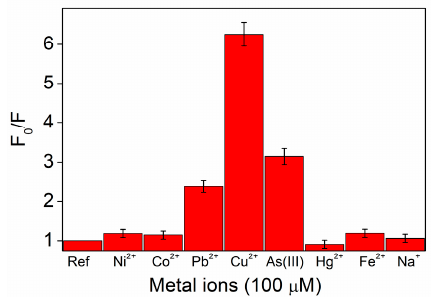
Figure 4. Fluorescence intensity ratio F 0 /F of the UFQD reference solution in the absence and presence of various individual metal ions at a concentration of 100 μ M. of various individual metal ions at a concentration of 100 µ